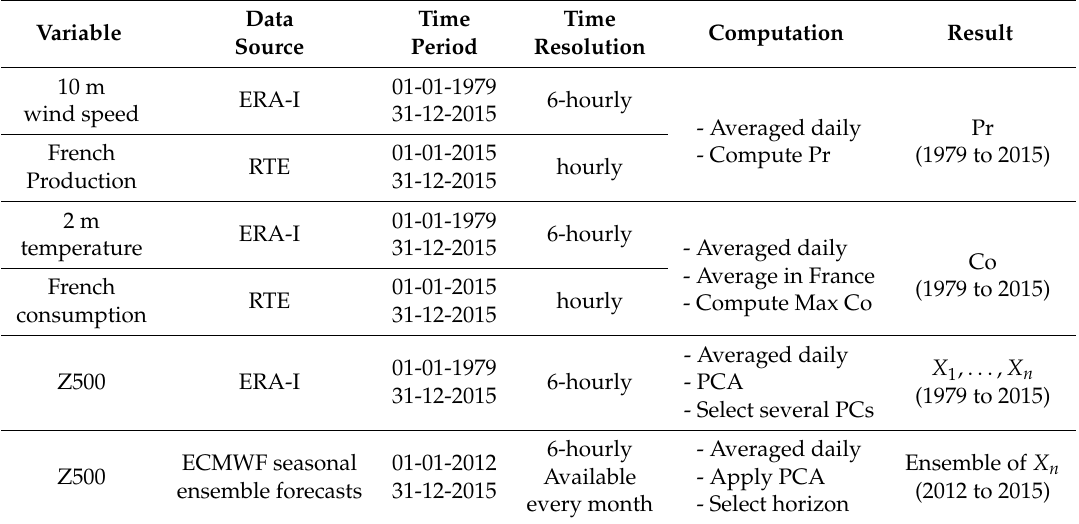
Table 1. Summary of the data used for this study as well as of their